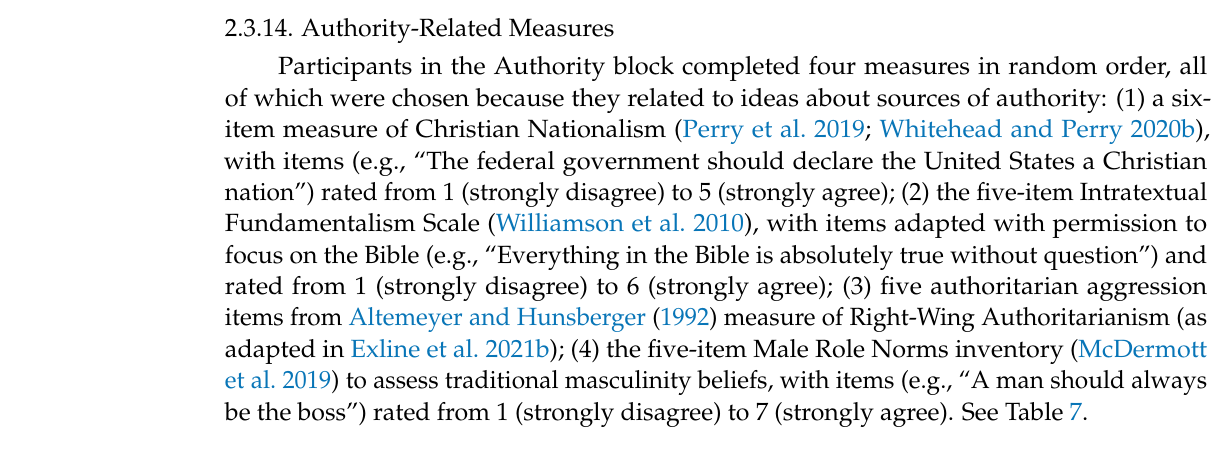
Table 7. Individual-Difference and Authority-Related Variables: Descriptive Statistics and Correla- tions with Demonic and Divine Vaccine